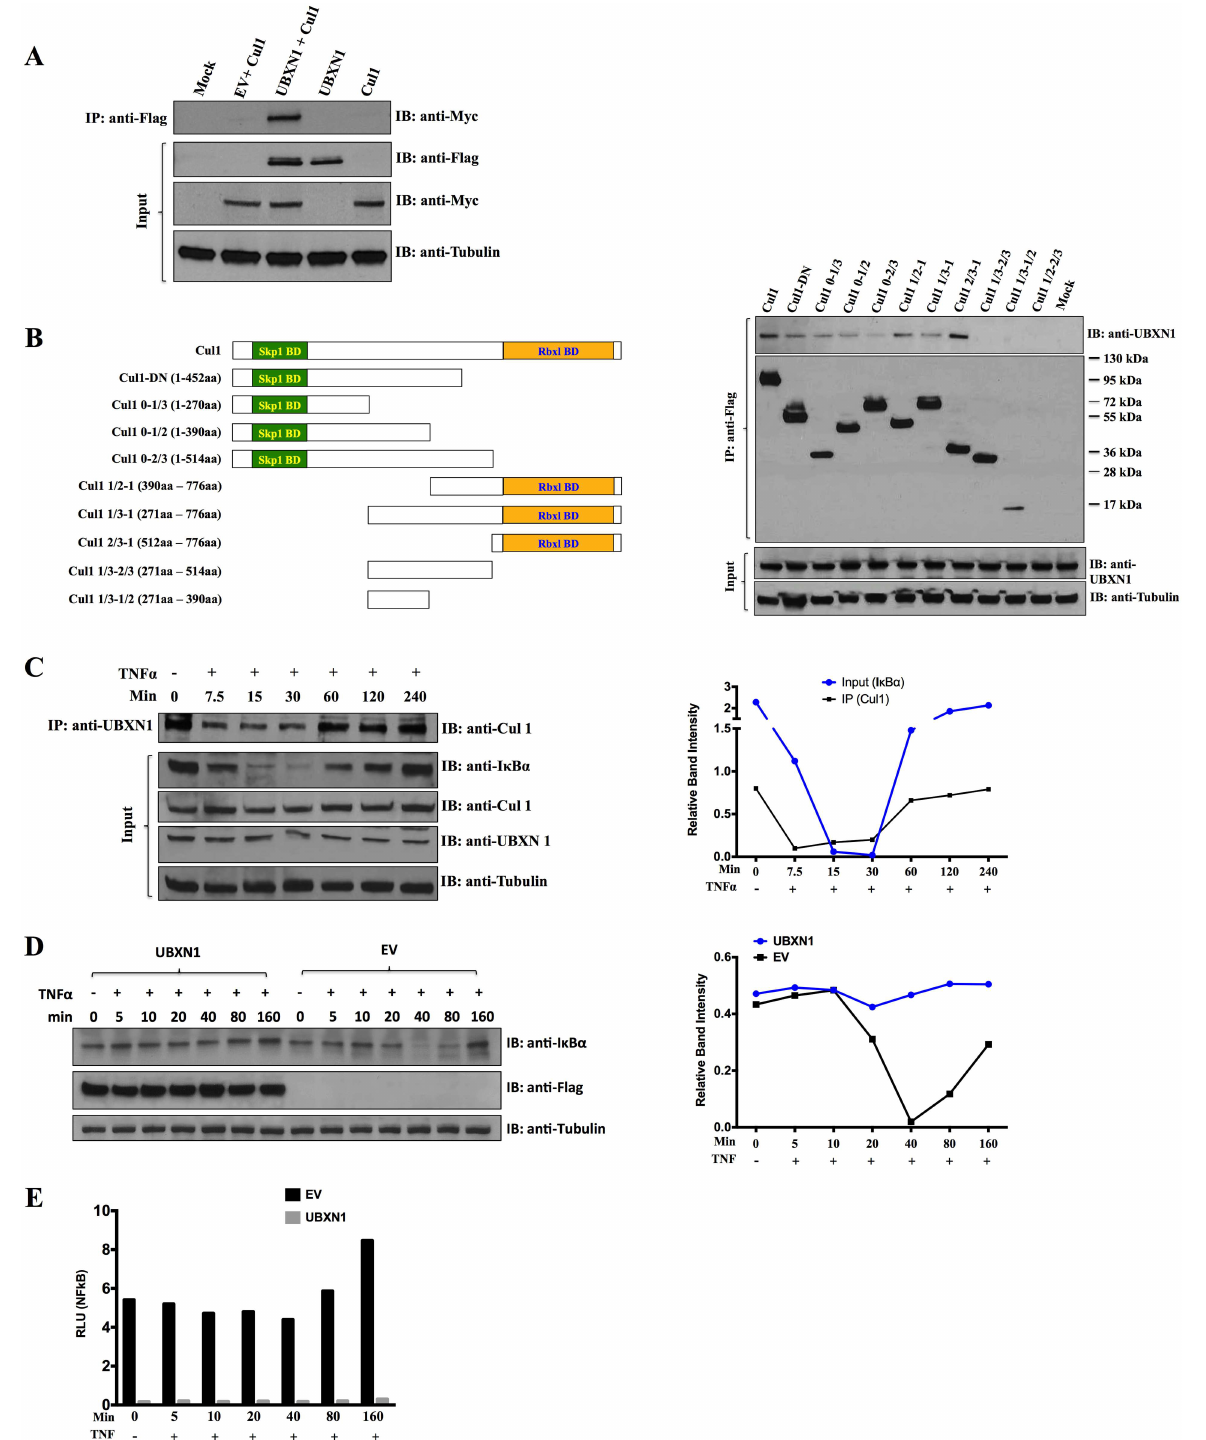
Fig 3. UBXN1 interacts with Cullin1 and prevents I κ B α degradation. (A) FLAG-UBXN1 was co-transfected with Myc-Cul1, as indicated, and immunoprecipitated(IP) using anti-FLAG antibody,followedby immunoblotting (IB) using anti-FLAG or Myc antibody; β − tubulinserved as loadingcontrol; (B) Left: schematic of Cul1 deletionconstructs, with indicatedregions that bind to Skp1 and Rbx1 (green and yellow, respectively, not preciselyto scale); right: FLAG-Cul1 constructs were transfected into HEK293 cells, as indicatedat top; endogenousUBXN1 was detected using anti-UBXN1 antibody and β− tubulinagainserved as loadingcontrol; (C) left: At top: Co-IP